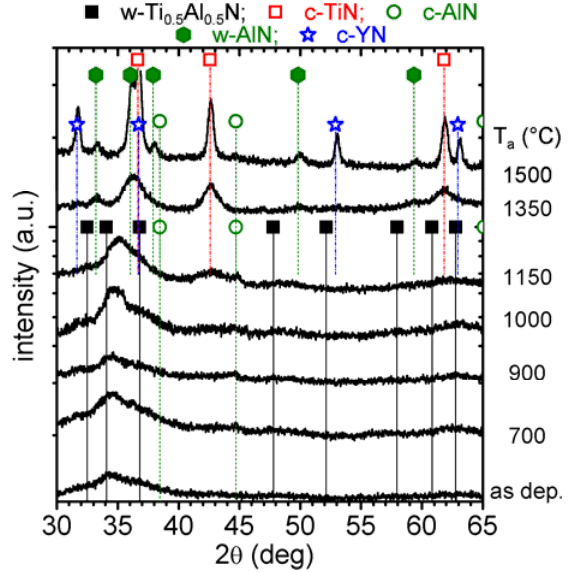
Figure 10. XRD evolution of single-phase w-Ti up to 1500 T a